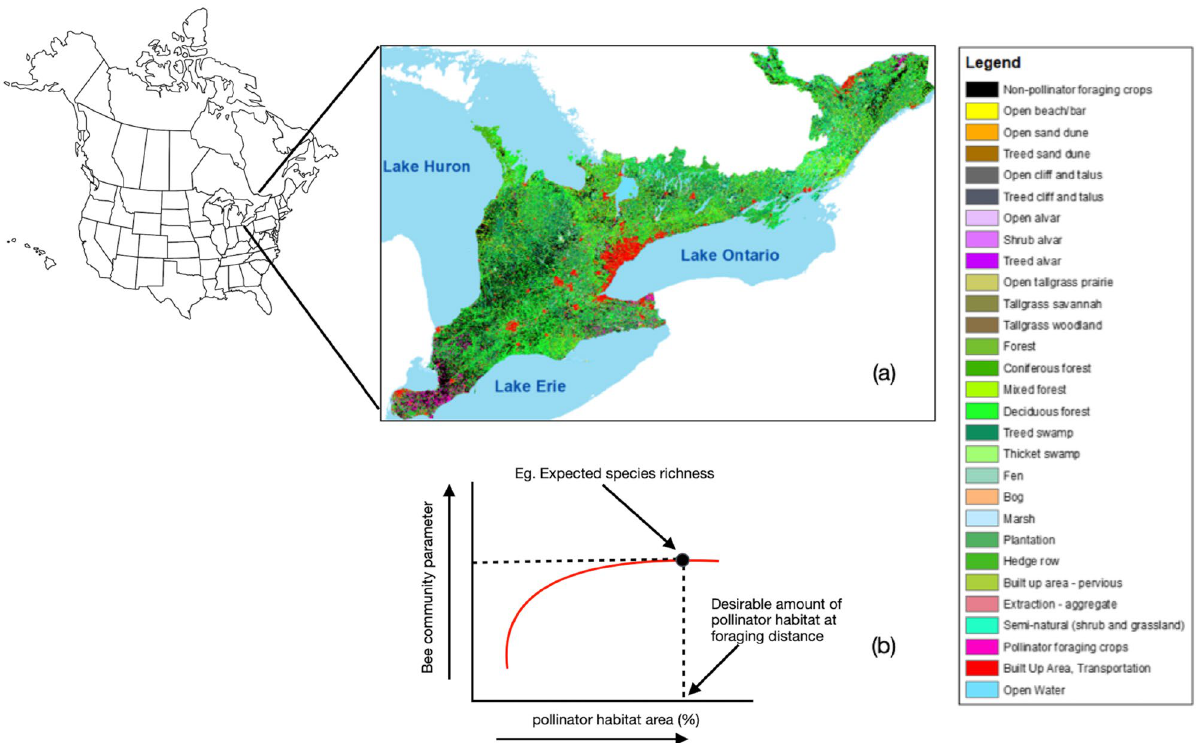
Figure 1. ( a ) Landscape gradient across Southern Ontario, Canada (Ecoregions 5E and 6E) a North American landscape. Red (urban areas), black (intensive wind pollinated crops), and light blue (open water areas) reflect areas that provide little or no pollinator habitat. Pink represents intensive agricultural crops that provide pollinator foraging habitat, while light- to darker-green colours represent a gradient of natural and